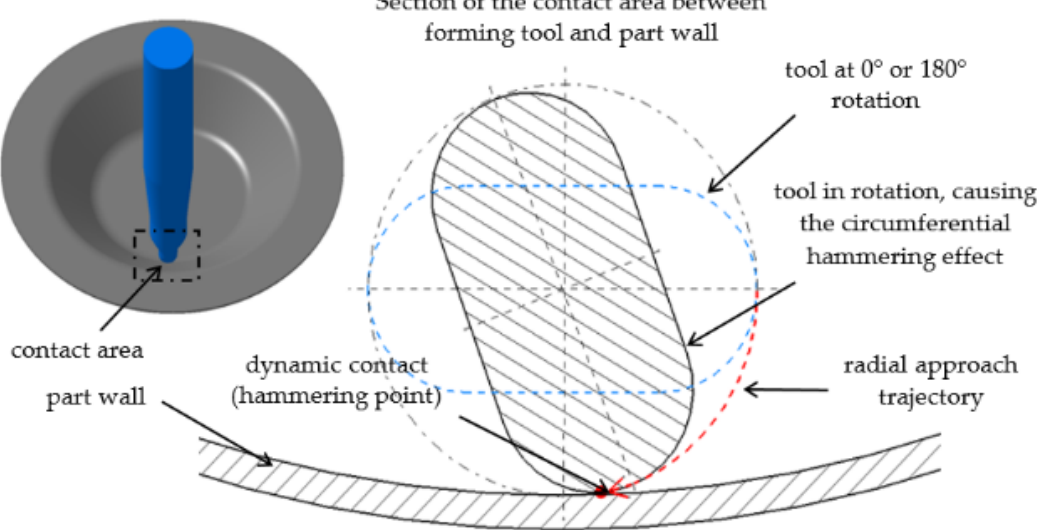
Figure 4. Circumferential hammering effect in the contact area between forming tool and part wall.